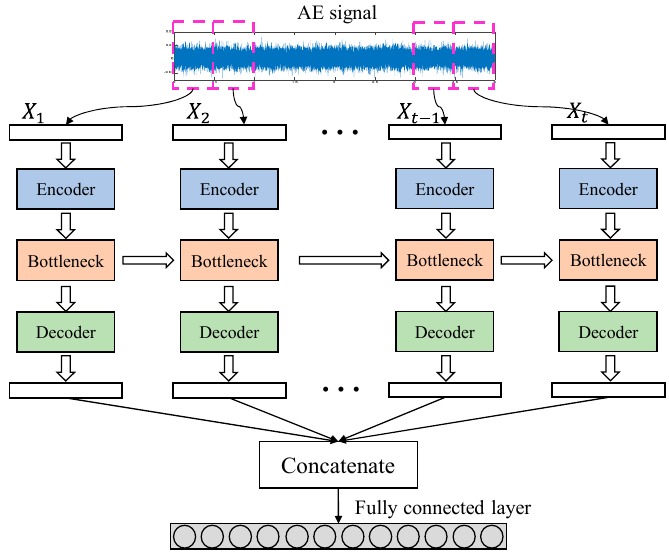
Figure 4. Illustration of the data flow within the Generator.